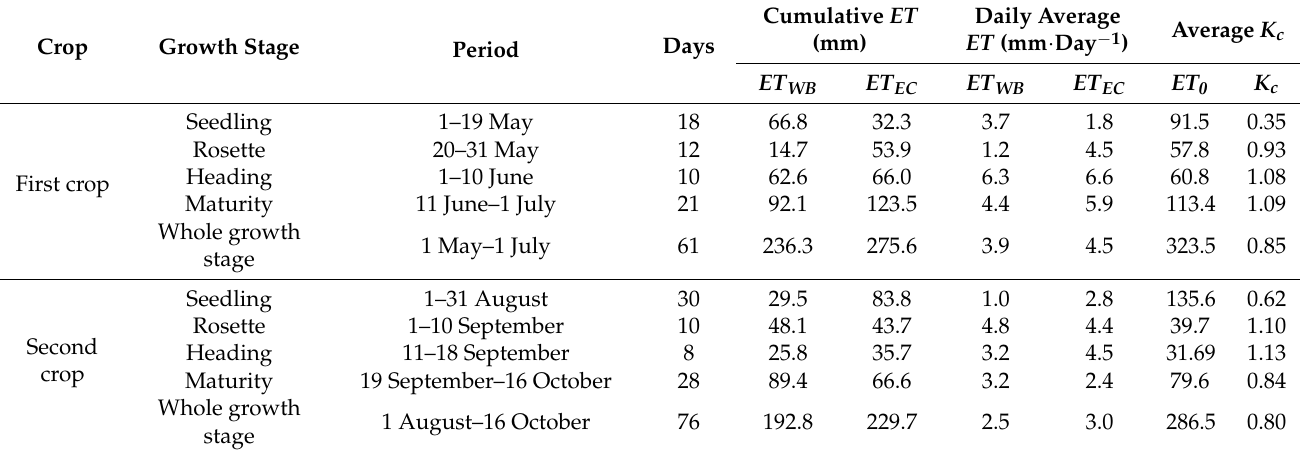
Table 2. ET of Chinese cabbage from water balance method, as well as ET and K c from eddy covariance measurement, over the whole growth